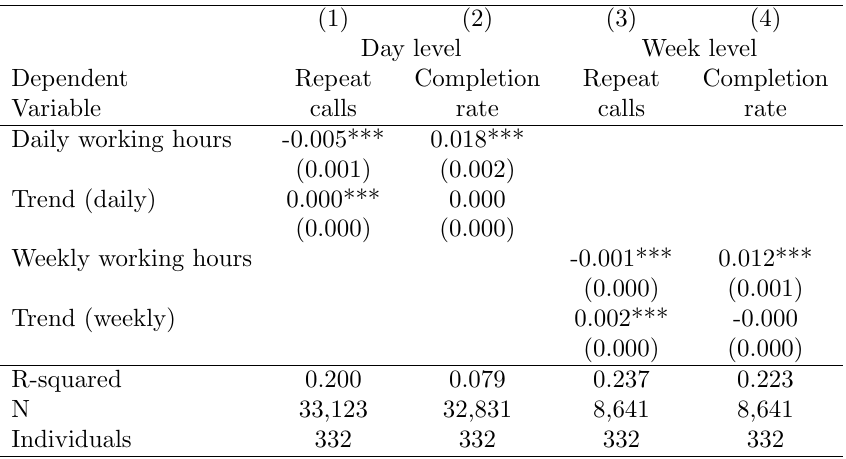
Table 6: Call quality and working